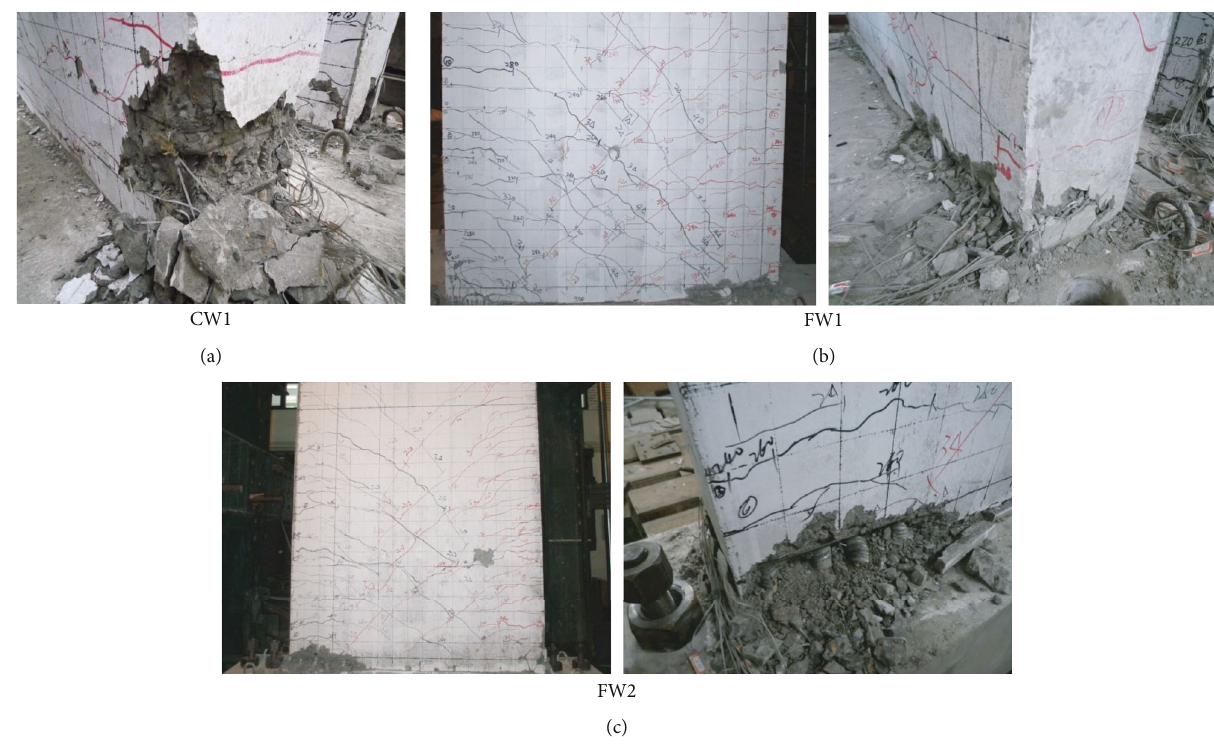
Figure 6: Cracking and damage of the